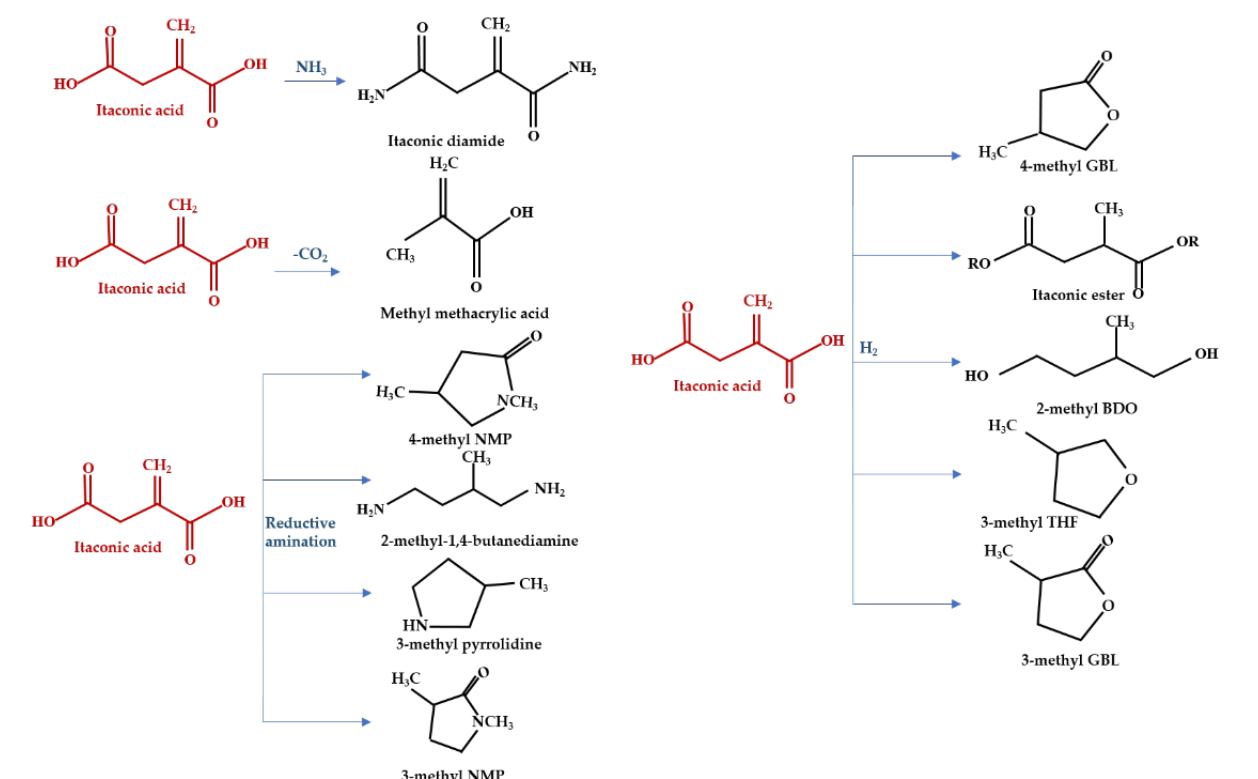
Figure 1. Itaconic acid (IA) conversion to advantageous by-product.